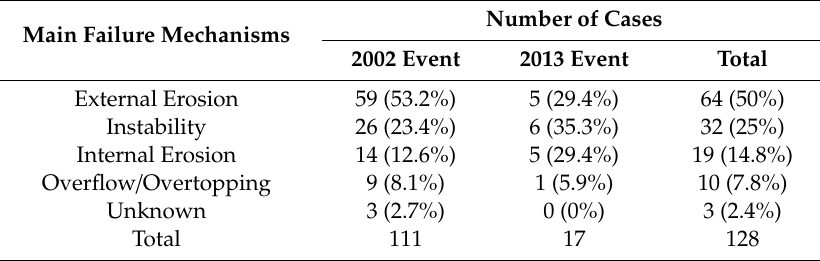
Table 2. Overview of the main failure mechanisms for the 2002 and 2013 events.